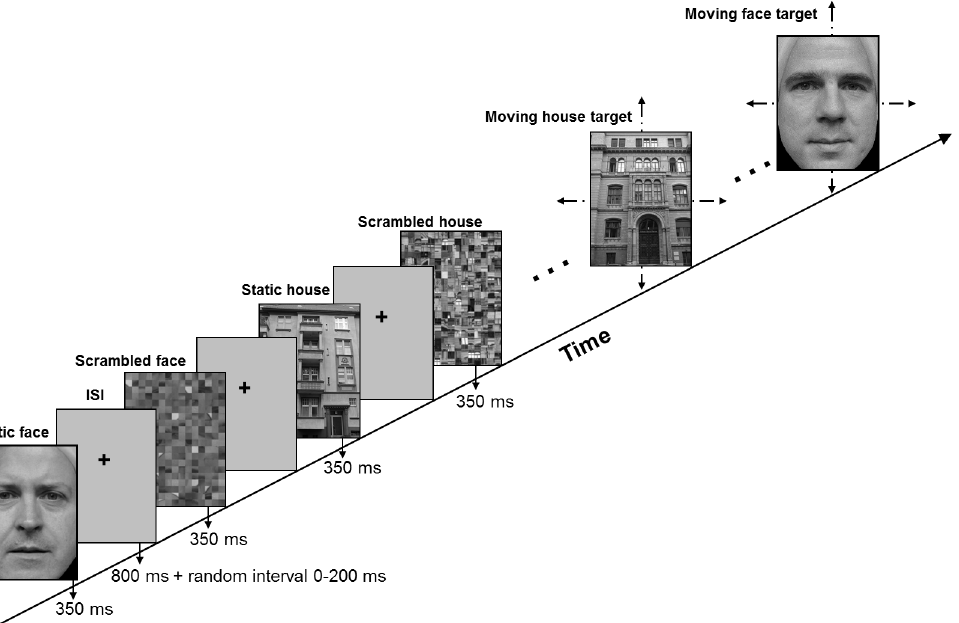
Fig 1. Stimuli and task for experiment 1 with two typical trials (face or house). The targets were inserted in the random sequence of faces and houses and persons responded differently to vertical or horizontal movement (illustrated by